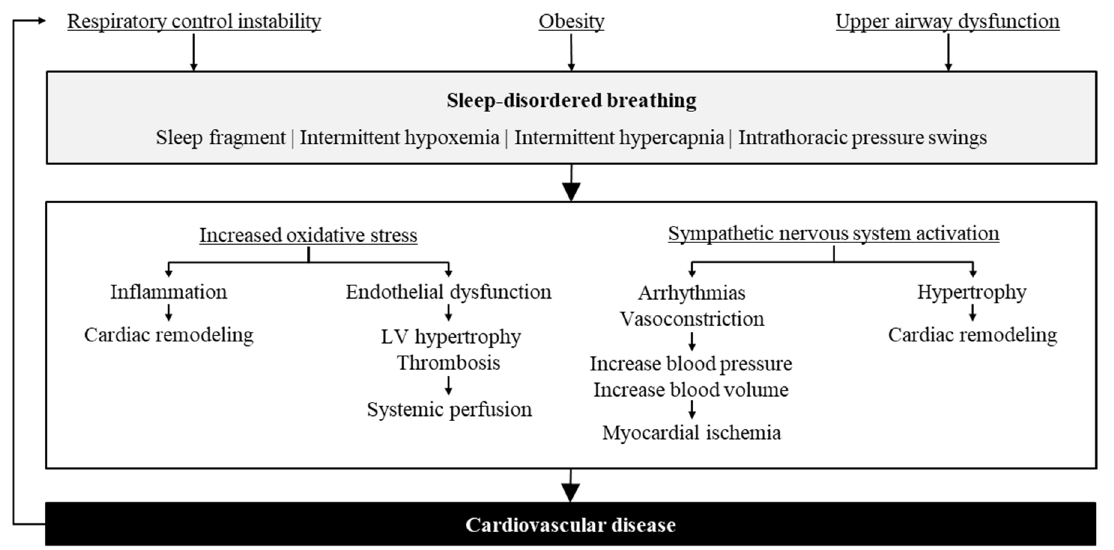
Figure 1. Pathophysiological consequence of sleep-disordered breathing and cardiovascular disease. LV = left ventricular.